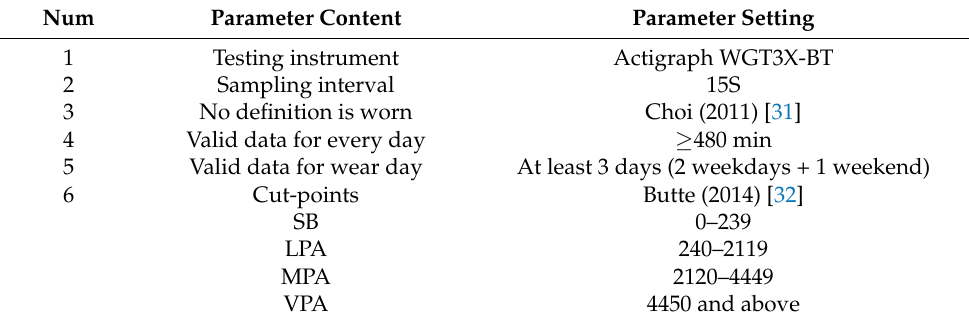
Table 1. Physical Activity Measurement Parameter Settings List of